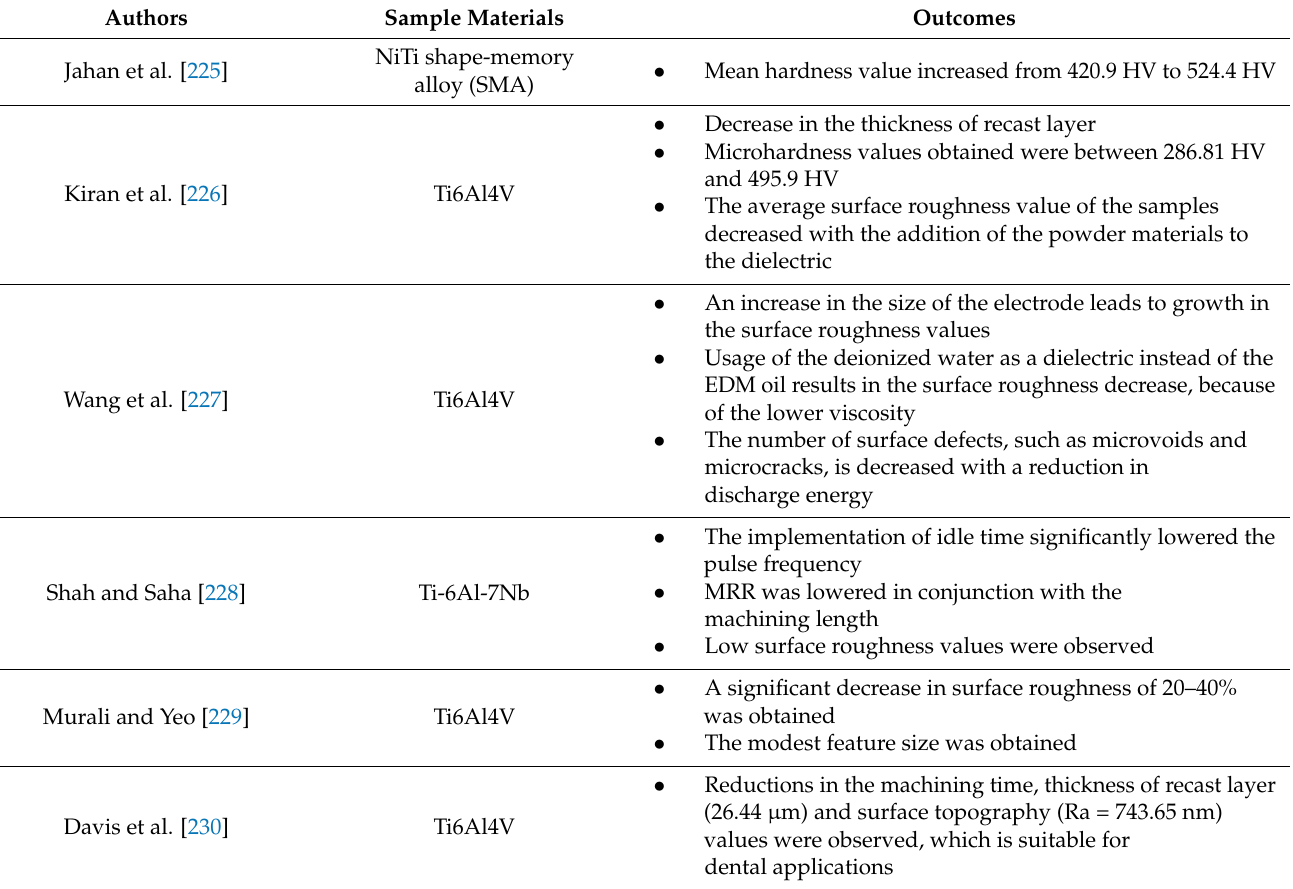
Table 16. Micro-EDM surface modification